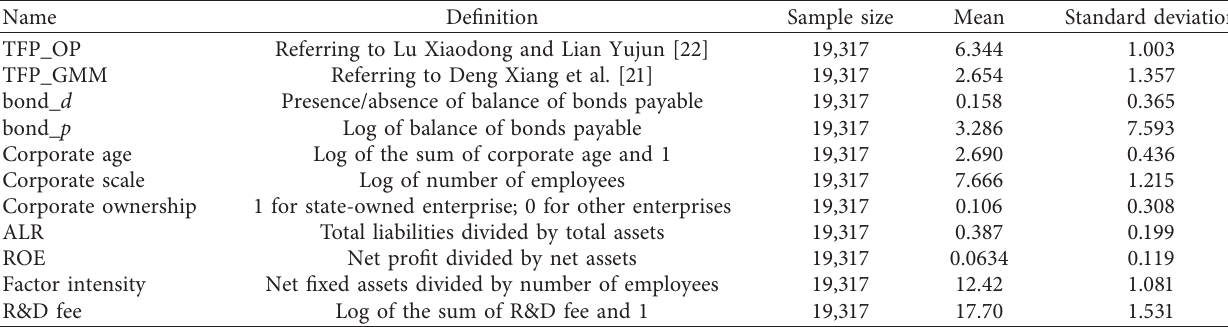
Table 1: Variable definition and description.